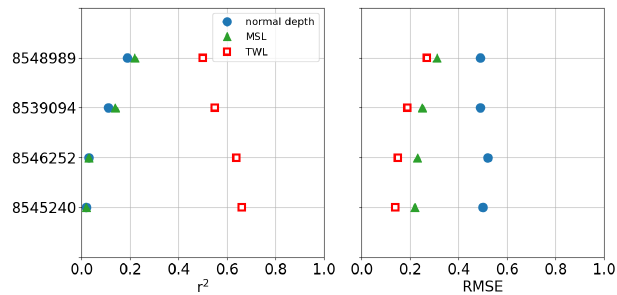
Figure 5. The r 2 and RMSE values of the MOSART simulations at the four NOAA